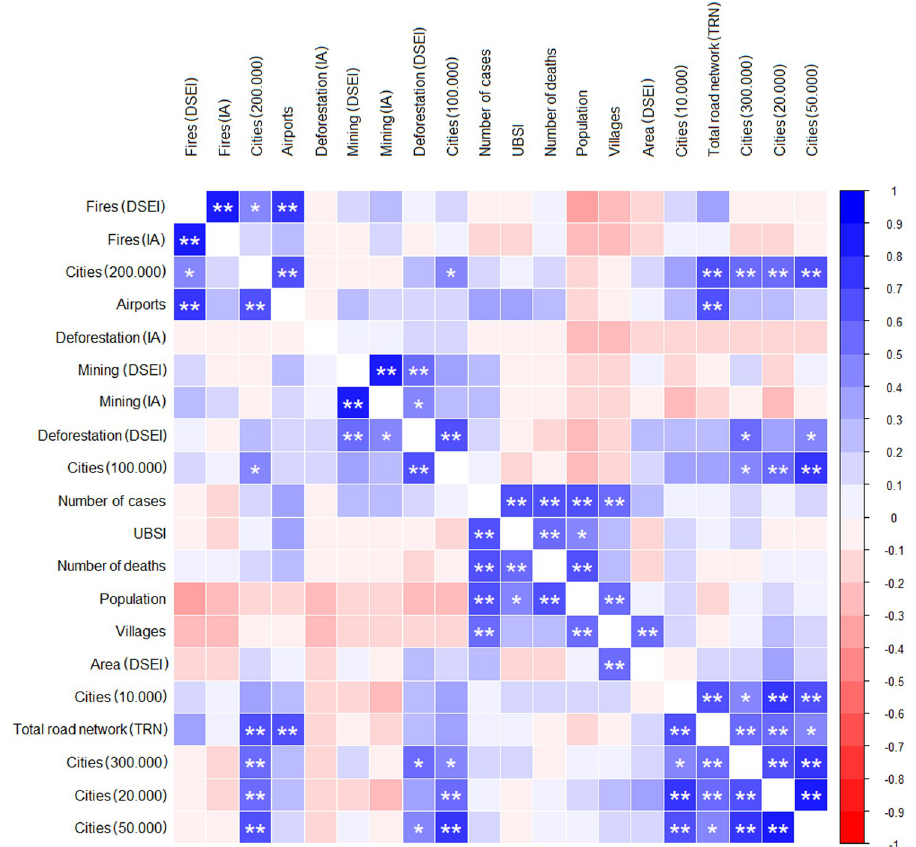
Fig 3. Correlation between indigenous health data (number of COVID-19 cases and deaths, number of UBSIs) and DSEIs (population; number of villages; area; number of cities with more than 10,000, 20,000, 50,000, 100,000, 200,000, and 300,000 inhabitants; total road network–TRN; and number of airports) and the landscape modification data (deforested area in DSEIs and in indigenous areas (IAs) within the DSEIs, deforested area due to fire and mining activity in DSEIs and IAs) observed for Brazil’s Legal Amazon in 2020. � significant at 5% probability; �� significant at 1% probability.